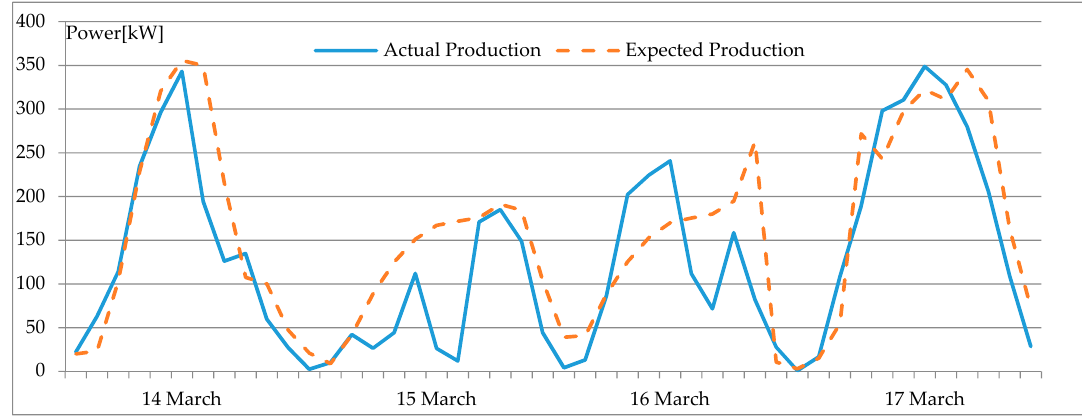
Figure 4. Non-clear sky forecast results; MAPE = 42%, nMAE = 6.8%.